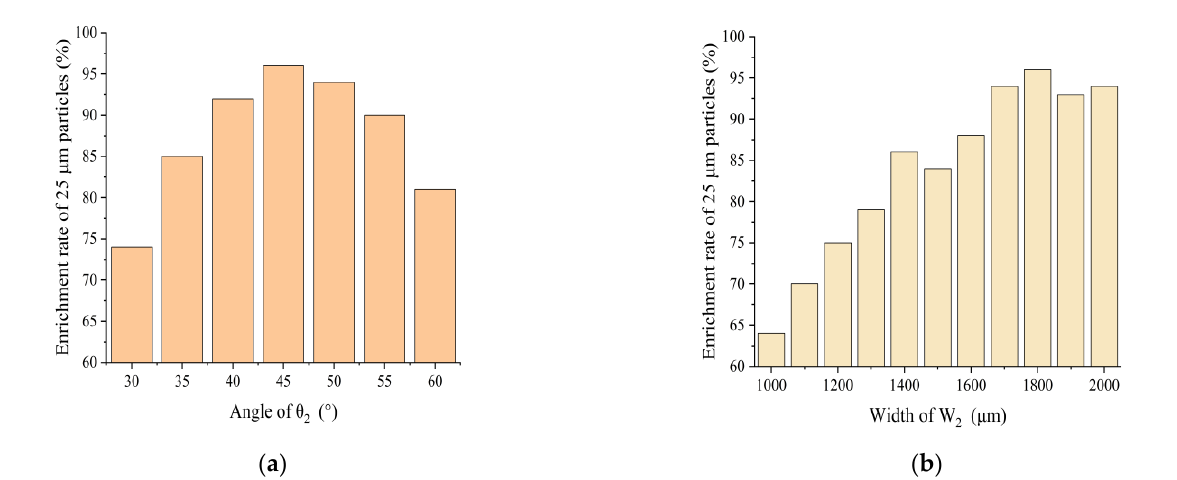
Figure 3. ( a ) Effect of θ 2 on enrichment efficiency of 25 μm particles; ( b ) effect of W 2 on enrichment effect of 25 μm particles.